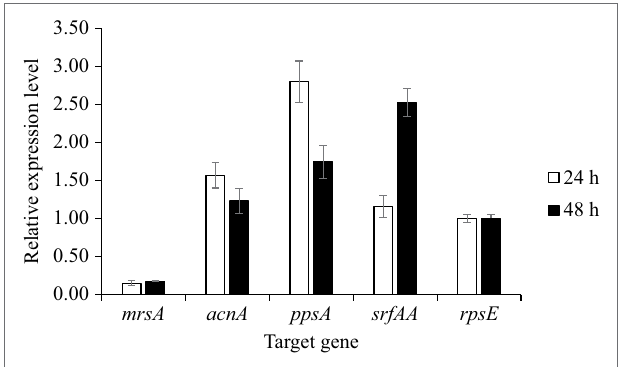
FIGURE 5 | Transcriptional activity of mrsA , ancA , ppsA, and srfAA genes in 24 and 48 h of B. velezensis cultivation. The housekeeping gene rpsE was used as the reference